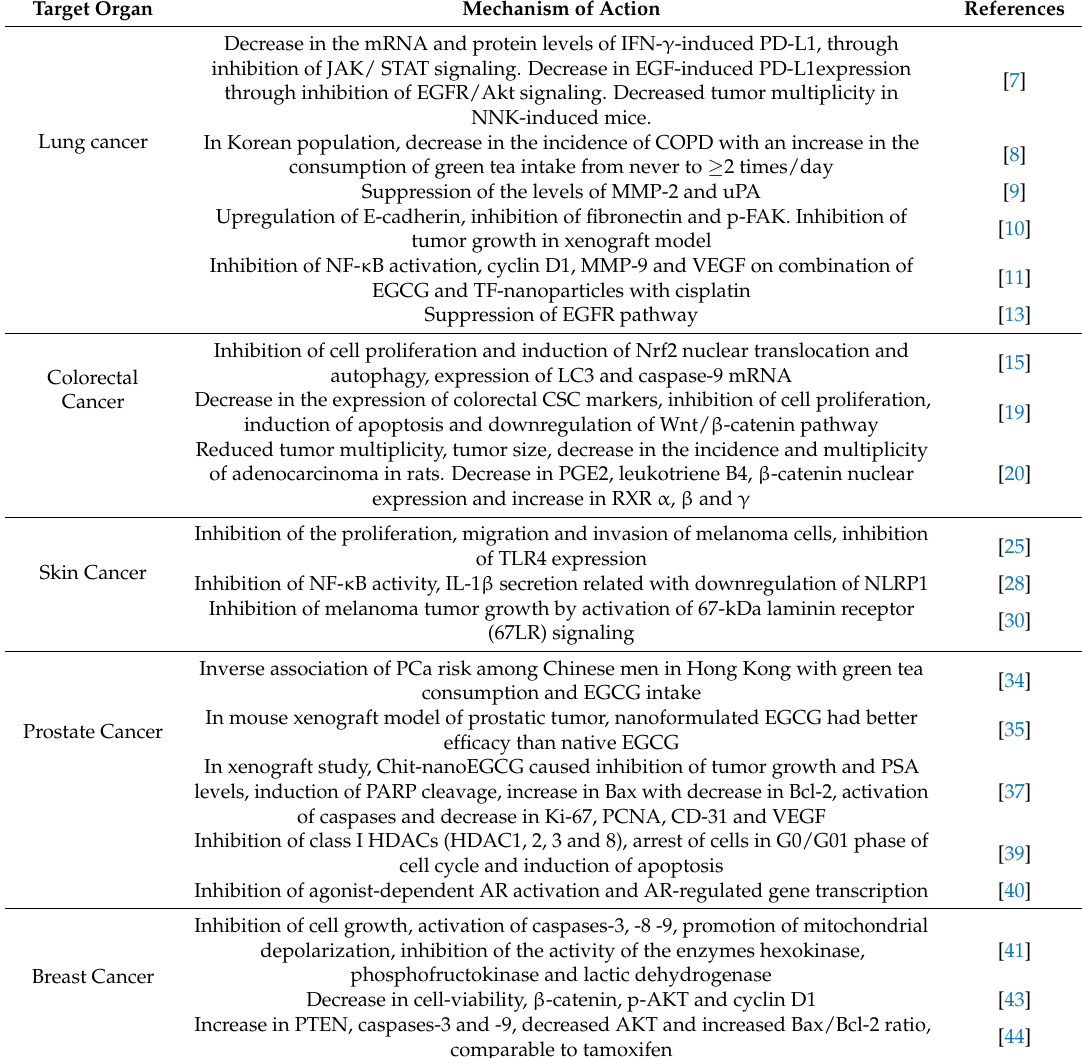
Table 1. Anticarcinogenic effects of tea polyphenols, reported from